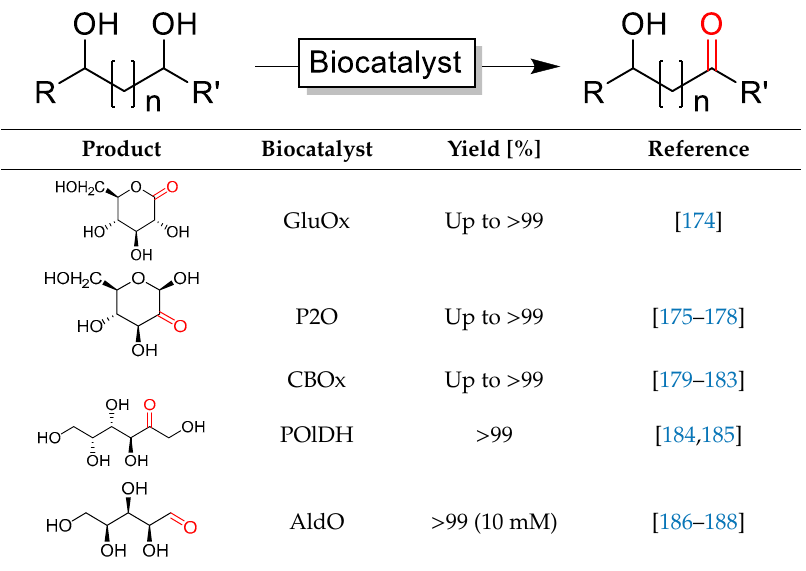
Table 4. Selection of biocatalytic oxidations of secondary alcohols.